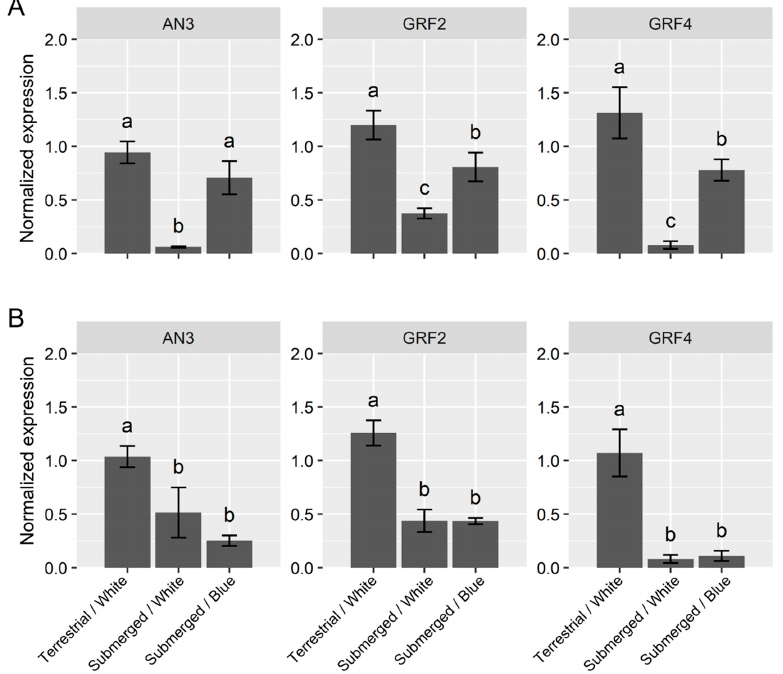
Figure 2. Expression profiles of cell proliferation-related genes after submergence. The plots indicate the relative expression normalized by ubiquitin5 (mean ± SE, n = 3) after 1 day ( A ) and 7 days treatment ( B ). The different letters denote significant differences among the experimental conditions (Tukey–Kramer test; the adjusted p -value < 0.05).